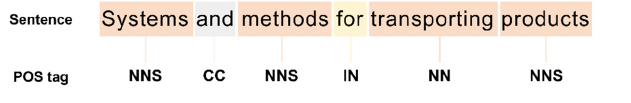
Figure 6. Collected UAV patent data.